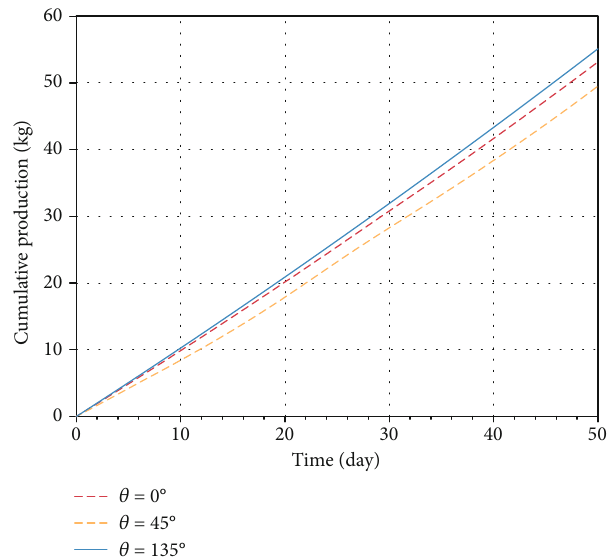
Figure 6: Cumulative production with di ff erent fracture orientations.